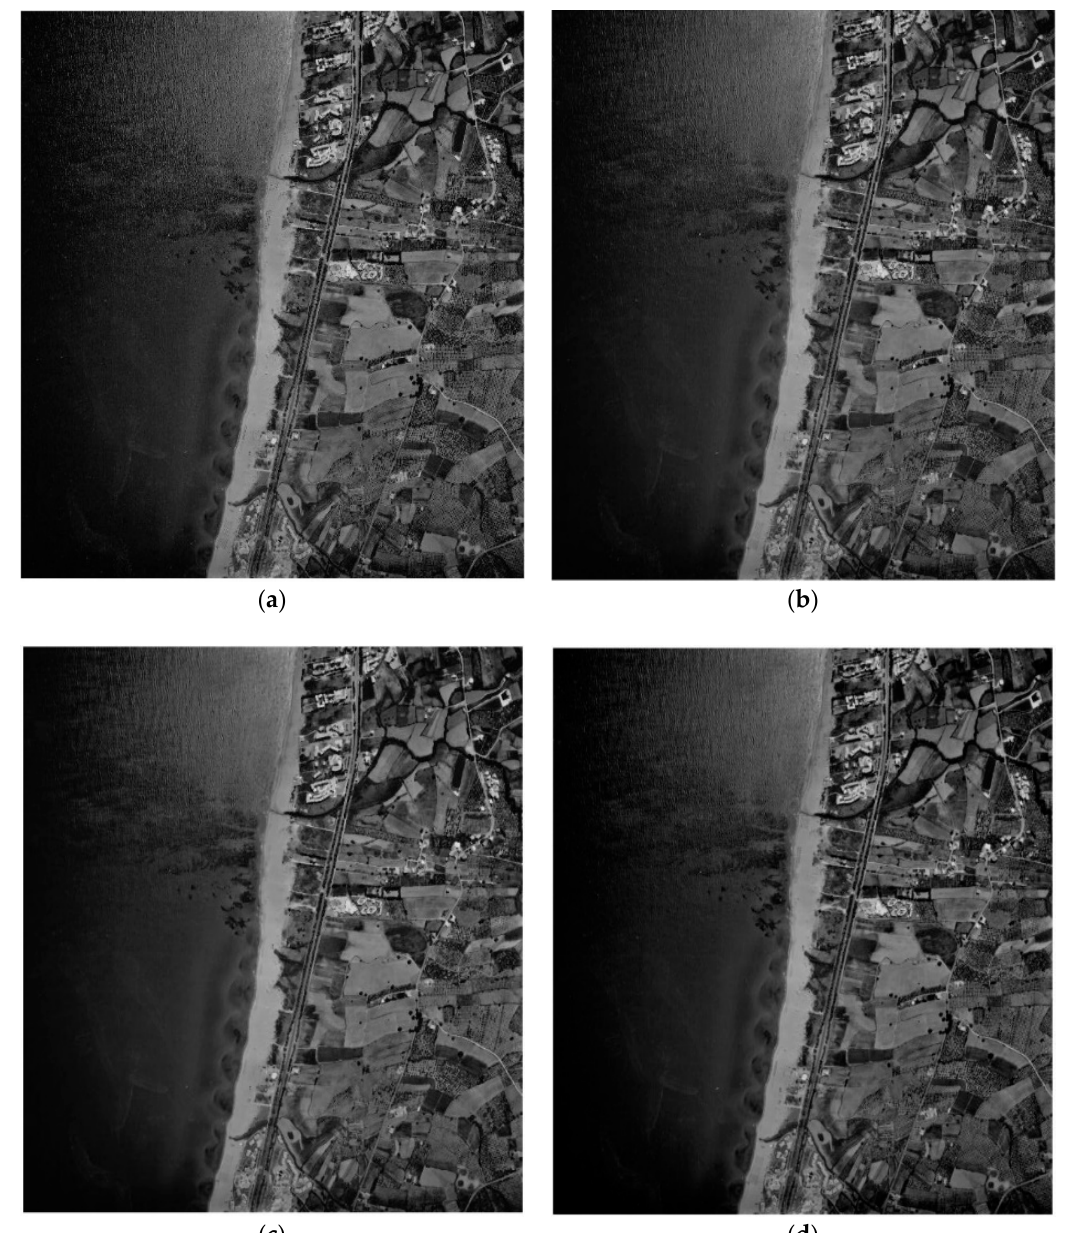
Figure 1. Filtering effect: ( a ) Initial image, ( b – d ) image after applying the Gaussian, Median, and Mean filters, respectively.